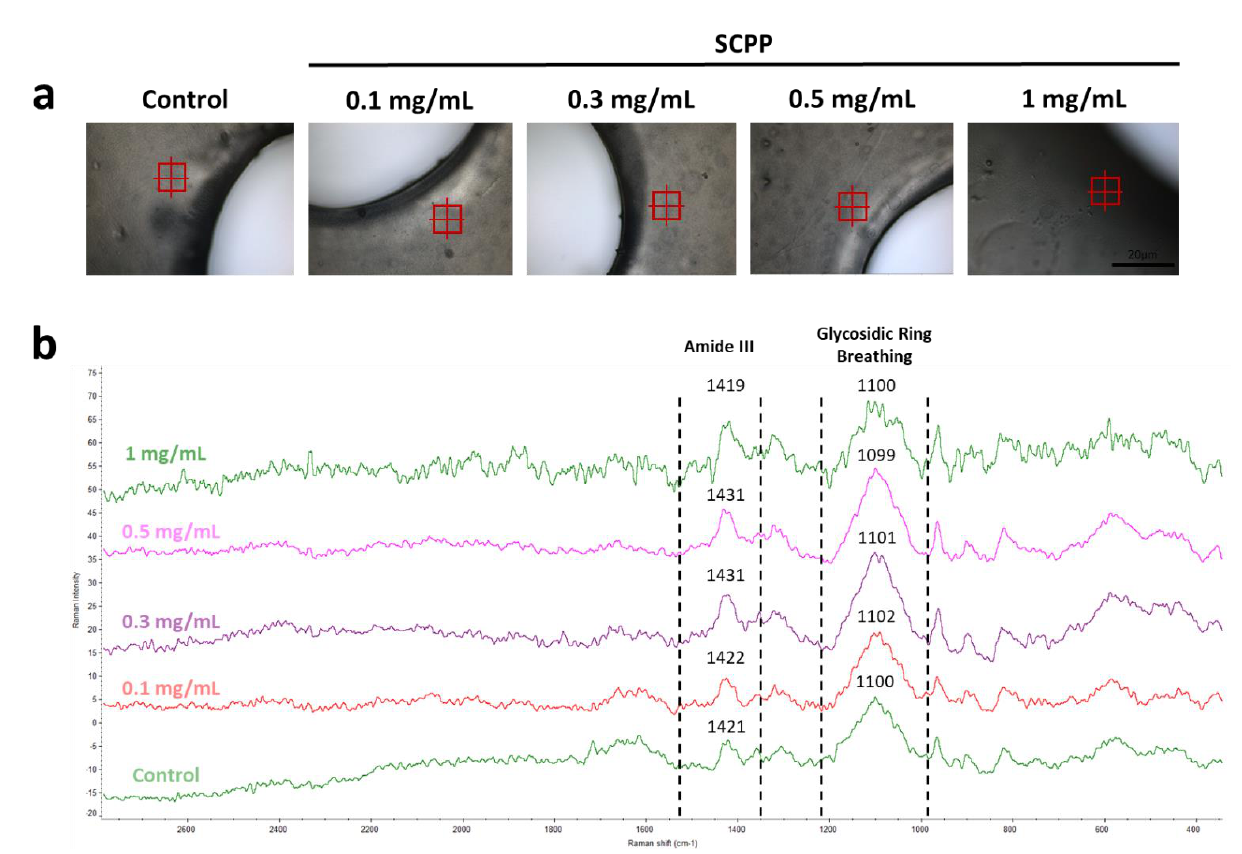
Figure 4. ( a ) Atl µ s view of the scaffolds’ topography under the Raman spectrometer. The red crosshairs indicate the region of interest targeted by the 528 nm laser from the Raman microscope. ( b ) The resultant Raman spectra after processing of the control, 0.1, 0.3, 0.5, and 1 mg/mL SCPP groups. Regions of amide III of collagen and the glycosidic ring within alginate were detected.